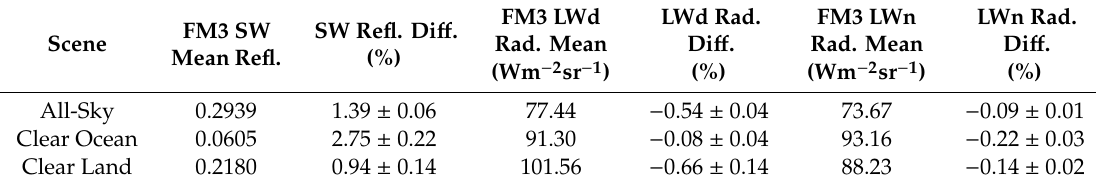
Table 1. Di ff erences in the global average shortwave (SW) reflectance, daytime longwave (LWd)